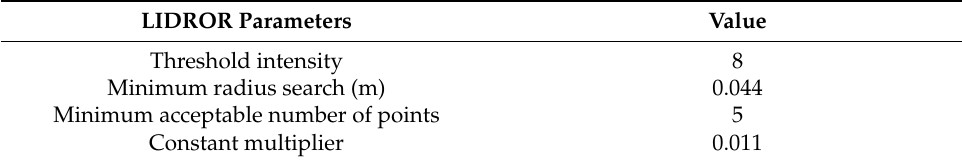
Table 3. LIDROR final parameters.